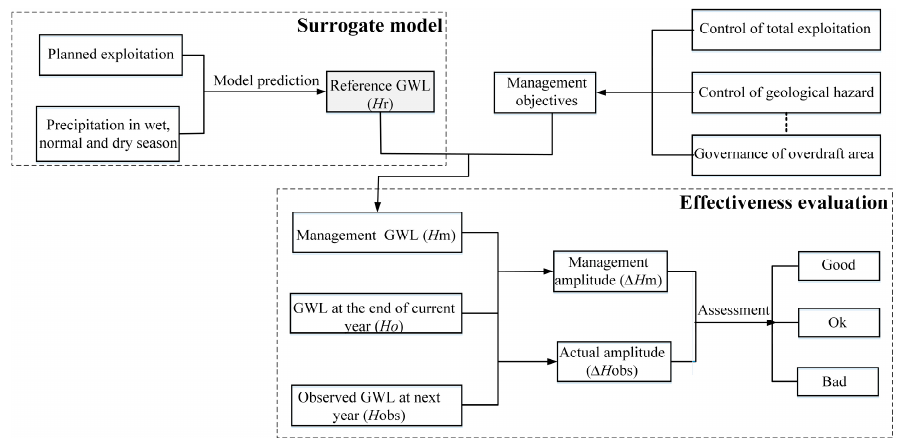
Figure 3. The process of groundwater management in the Beijing Plain.